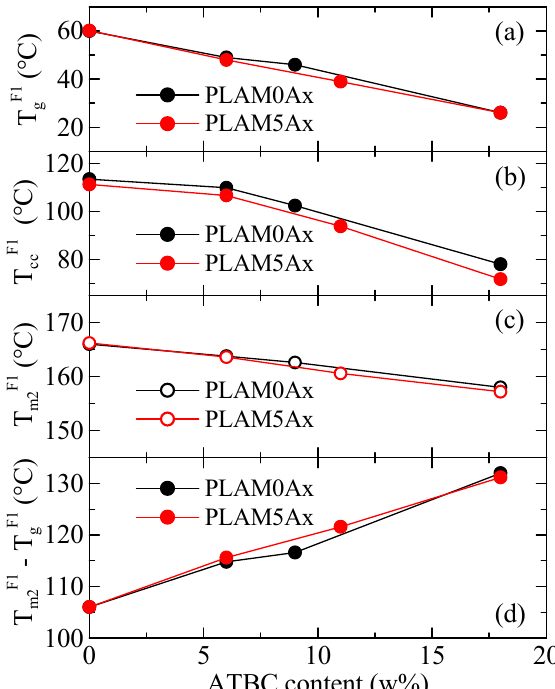
Figure 3. DSC first melting curves (endo up) at 10 °C/min of the different compression-molded materials. The vertical lines are the corresponding values reported in reference [22], showing the temperature intervals where the pure α ’ or α modifications are expected to be observed (or the in- terval where both forms coexist) in this PLA under analysis.